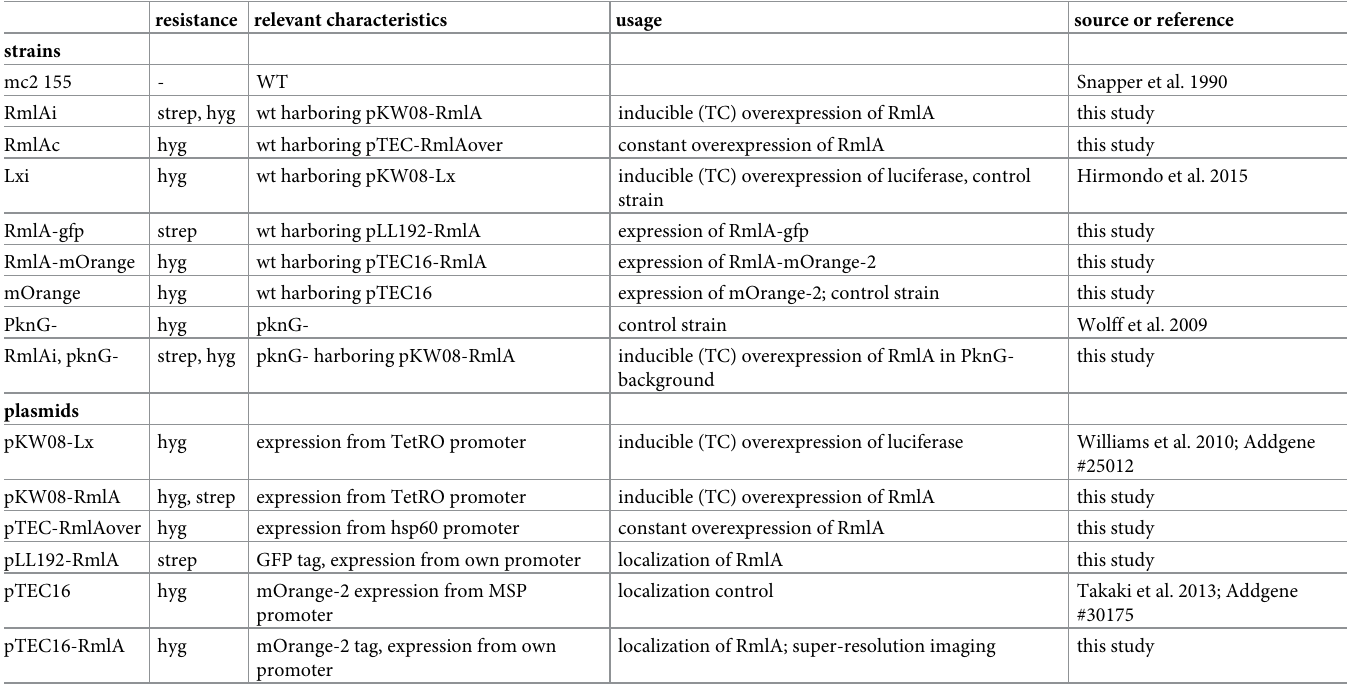
Table 1. Strains and plasmids used in the study. resistance relevant